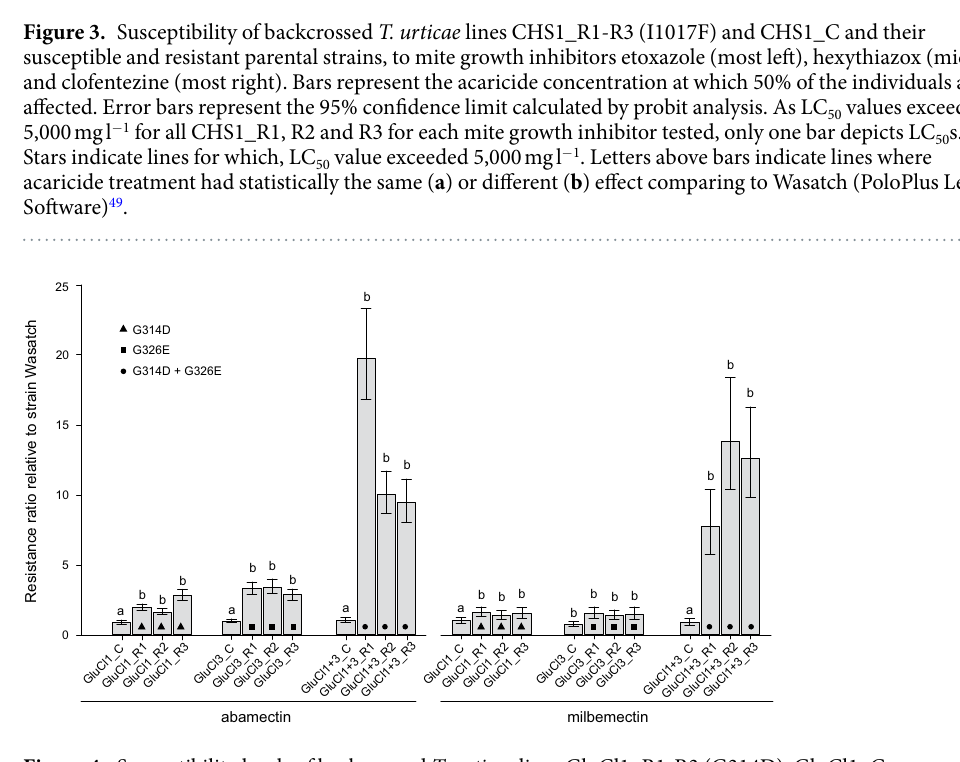
by 5 different GluCl genes. Hence, if the channel consists of a combination of subunits carrying the resistance associated substitution (GluCl1 and/or GluCl3) and a GluCl2 subunit (GluCl2 does not carry a resistance asso- ciated substitution, while GluCl4 and GluCl5 naturally carry substitutions that interfere with abamectin binding see Dermauw, et al . 35 ), abamectin binding might still be possible. In addition, we cannot exclude the possibility of heteromeric channel assembly, consisting of GluCls and GABACl 18, 19 . In such case, the existence of mutations in GluCl1 and GluCl3 alone would also not be capable to fully prevent channel blocking. Consequently, our results